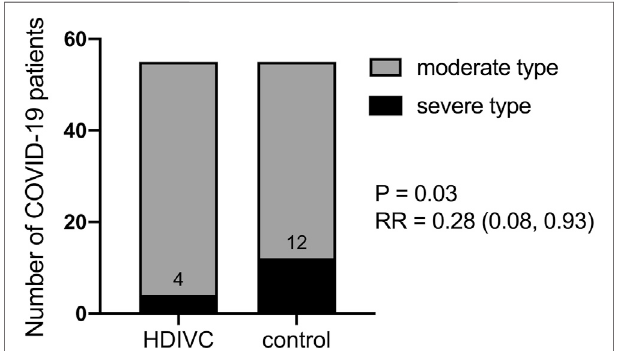
FIGURE 2 | Effect of HDIVC on preventing the disease aggravation. The number of patients who experienced disease aggravation in HDIVC and the control group were compared (4/55 vs 12/55, RR (cid:1) 0.28 [0.08, 093], P (cid:1) 0.03). HDIVC, high dose intravenous vitamin C; COVID-19, coronavirus disease 2019; RR, relative risk; CI, con fi dential